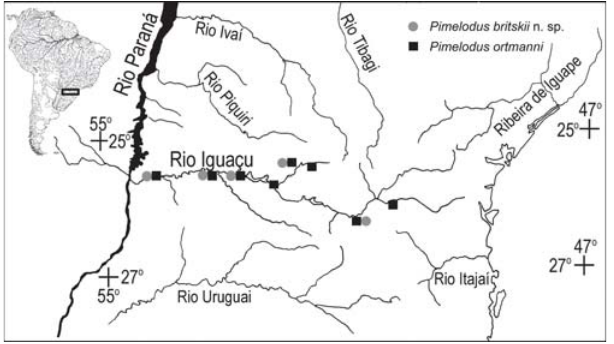
Fig. 3. Geographical distribution of Pimelodus ortmanni and Pimelodus britskii from Rio Iguaçu. Each symbol may represent more than one